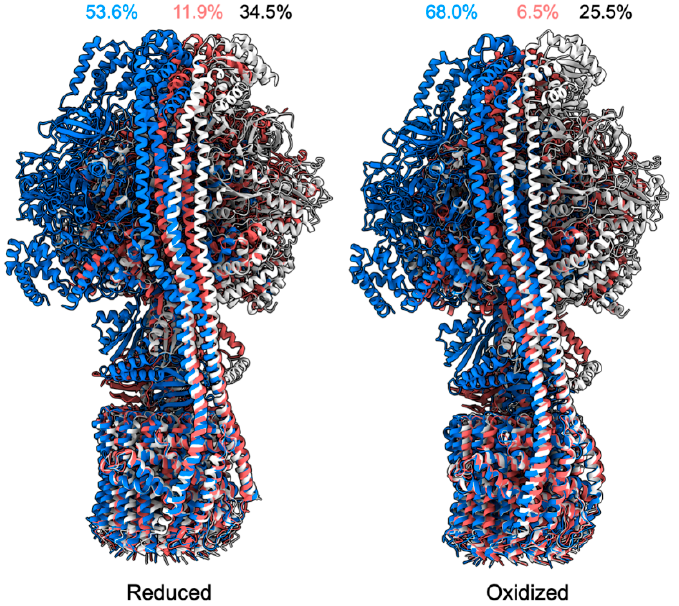
Figure 3. Redox states of chloroplast ATP synthase [57]. Blue, white, and salmon are different rotary states of the ATP synthase. Percentages labeled are the particle proportions within those in individual redox states.